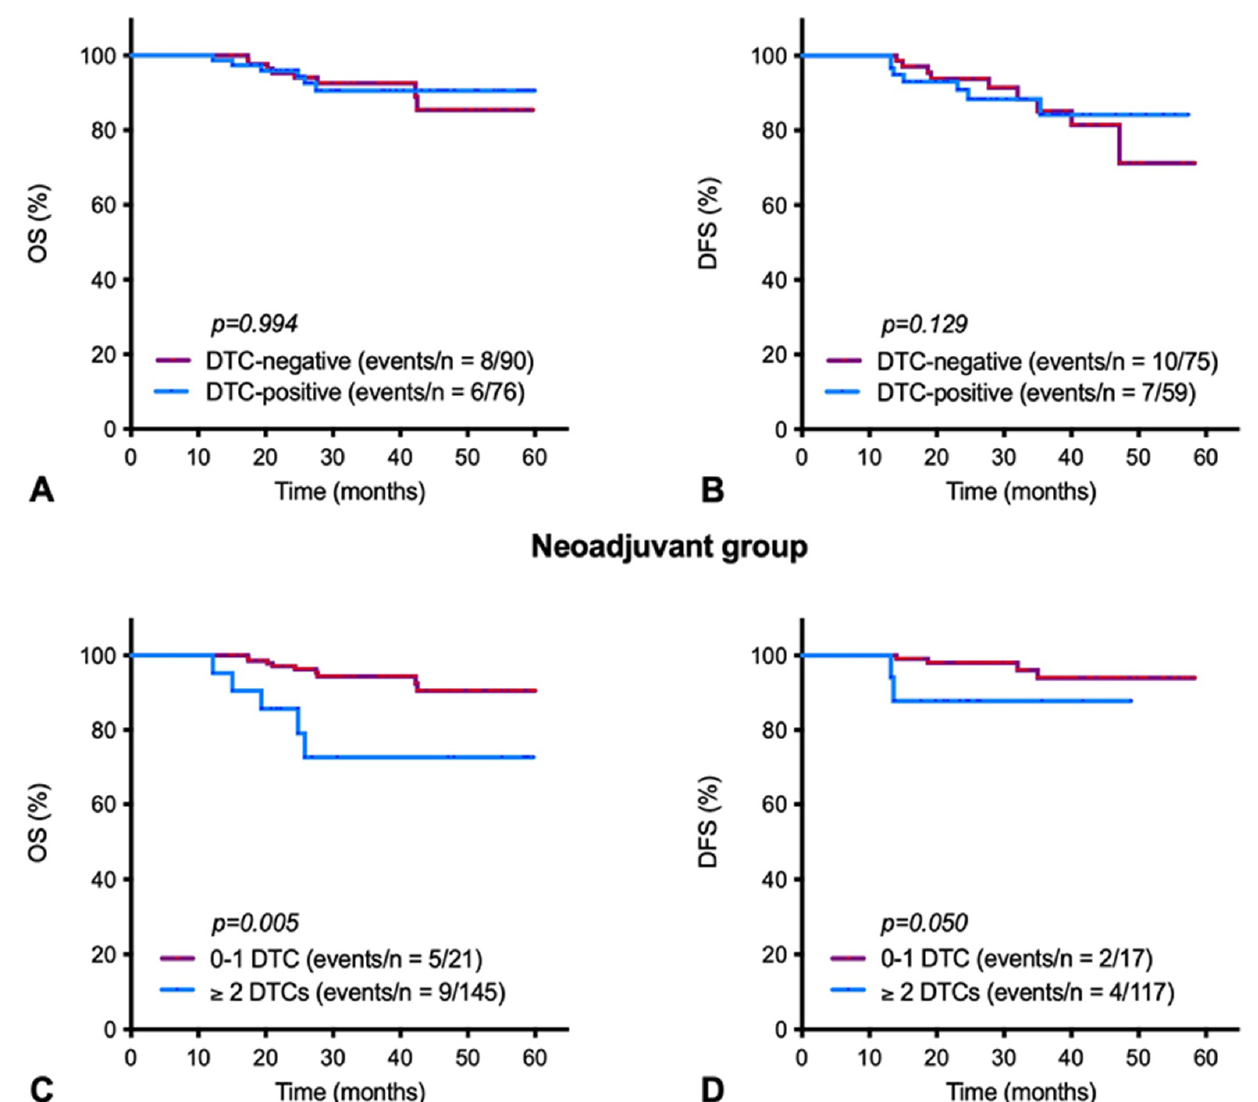
Figure 1. Univariate survival analysis by disseminated tumor cell (DTC) status after neoadjuvant chemotherapy. Kaplan–Maier plots of ( A , C ) overall survival (OS) and ( B , D ) disease-free survival (DFS) for DTC detection in bone marrow samples of patients who had received neoadjuvant chemotherapy. ( A , B ) DTC-negative patients (purple line) as compared to DTC-positive patients and ( C , D ) patients with 0-1 DTCs per 1.5 × 10 6 mononuclear cells (purple line) as compared to patients with ≥ 2 DTCs/1.5 × 10 6 mononuclear cells (blue